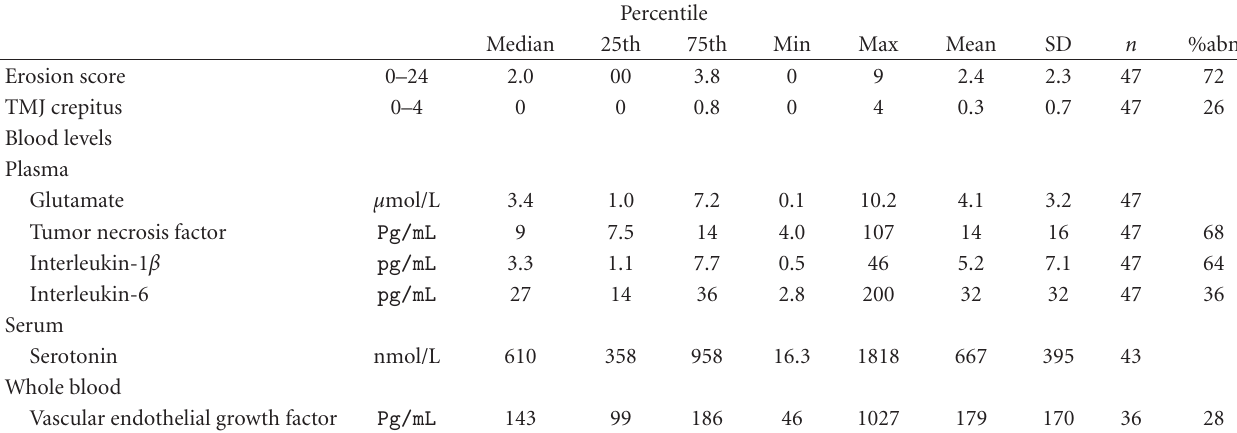
Table 2: Erosion score as well as level of TMJ erosion score and inflammatory mediators in blood samples from 47 patients with early rheumatoid arthritis.